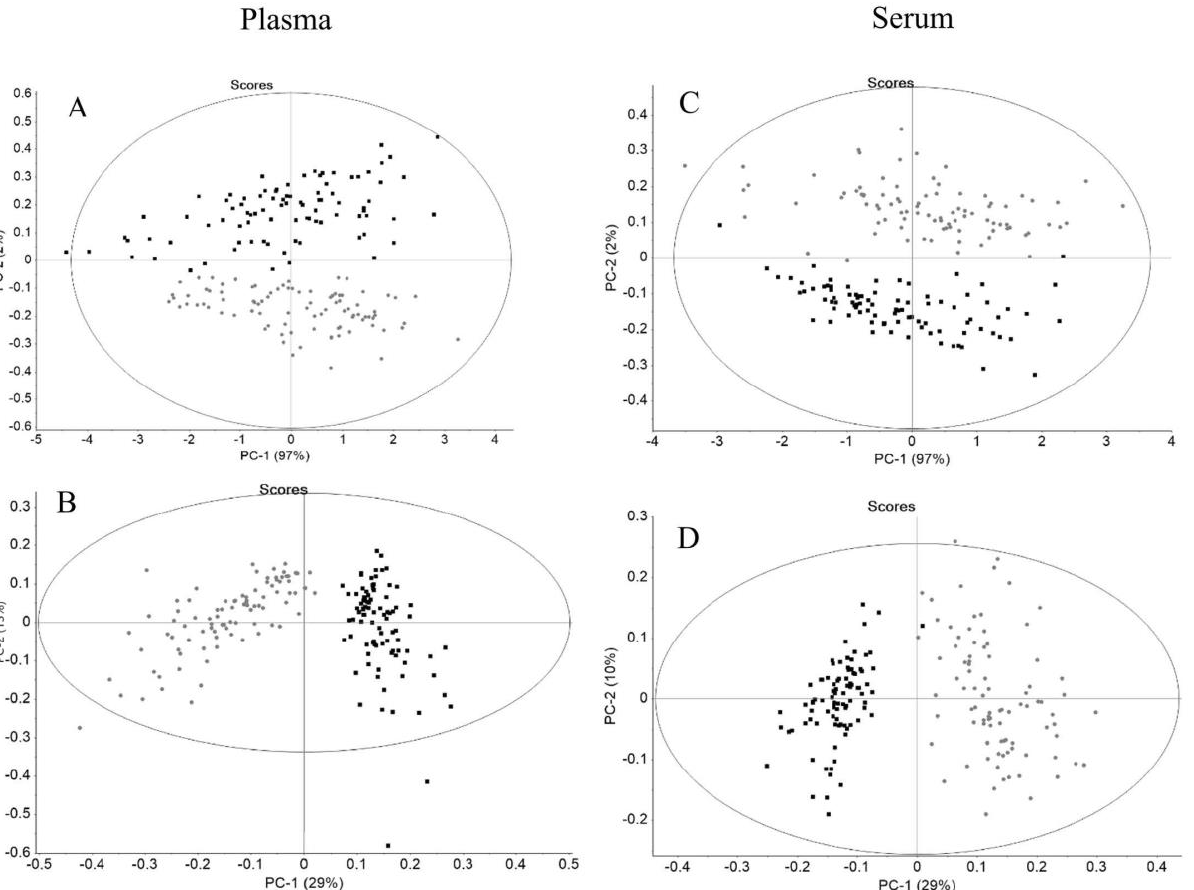
Figure 2. PCA of plasma ( A , B ) and serum ( C , D ) with spectra pre-processed by atmospheric and baseline correction ( A , C ) and second derivative and unit vector normalization ( B , D ) relative to T0 (grey symbols) and T90 (black symbols), respectively, with Hotelling’s T 2 ellipse at a 99% confidence